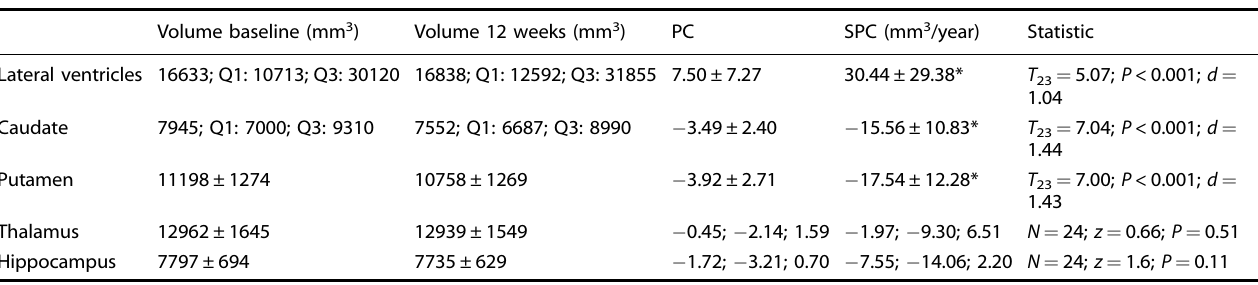
Table 2. Subcortical volumes at before and 12 weeks after clozapine initiation.